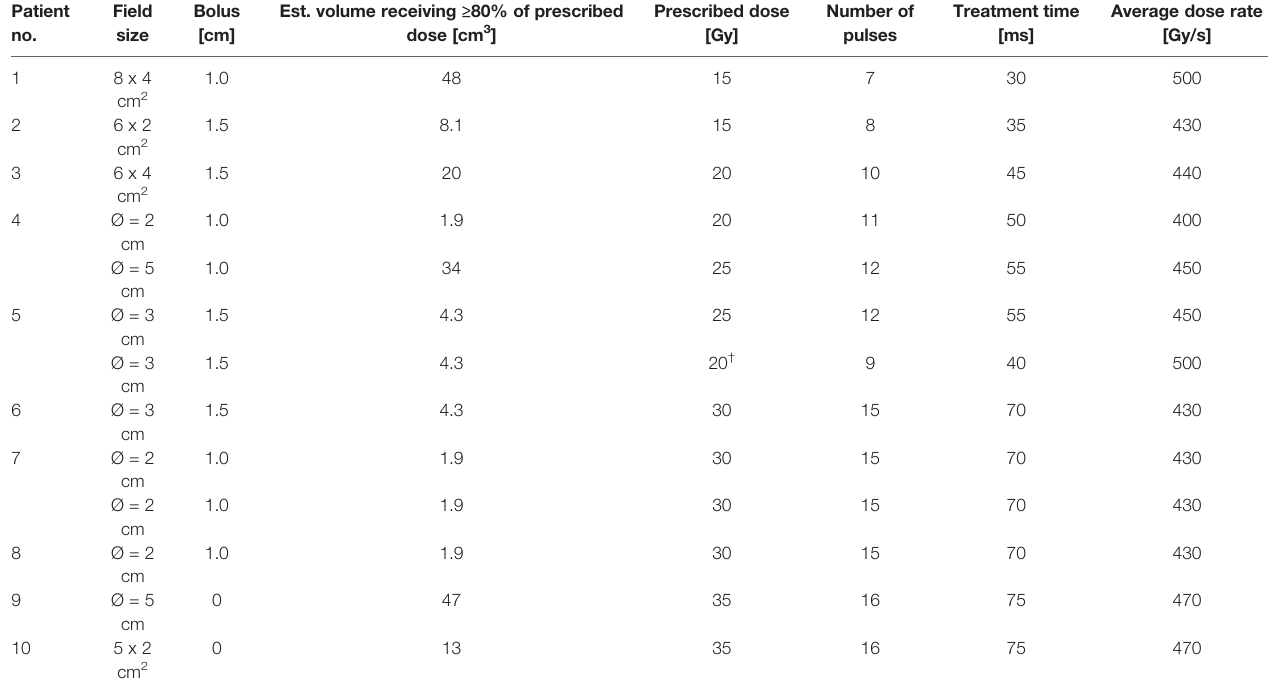
TABLE 2 | Treatment parameters for the ten canine patients. Patient no.